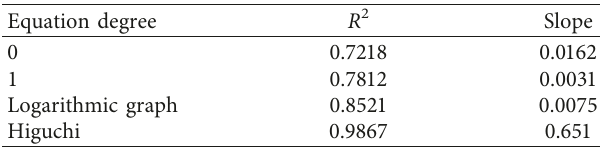
Figure 5: Antimicrobial activity of vancomycin and vancomycin/soy protein nanoparticles (vancomycin-SPNs) based on RDA test on Staphylococcus aureus (a) and Streptococcus pyogenes (b). Minimum inhibitory concentration (MIC) values for vancomycin and van- comycin-SPNs (c). (1) 15:05 (mg/ml of vancomycin:SPNs); (2) 10:15 (mg/ml of vancomycin:SPNs); (3) 6:20 (mg/ml of vancomycin:SPNs); (4) 8:25 (mg/ml of vancomycin:SPNs); (5) 10:30 (mg/ml of vancomycin:SPNs), and (6) vancomycin. Table 2: Drug release based on the zero, 1, logarithmic, and Higuchi equation of SPNs with ratios of 10/30